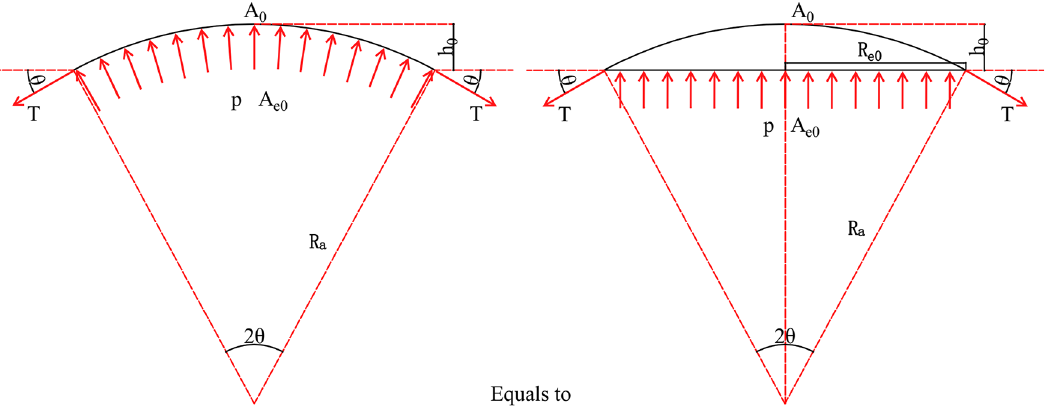
Fig. 8. The force diagram of the